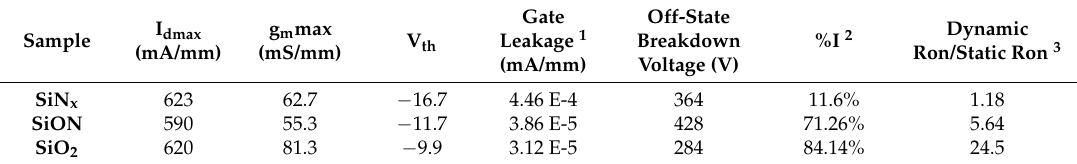
Figure 1. Metal–insulator–semiconductor high-electron-mobility transistors (MIS-HEMT) structure cross-section view. Table 2. Selected properties of SiN x , SiON, and SiO 2 MIS-HEMT.